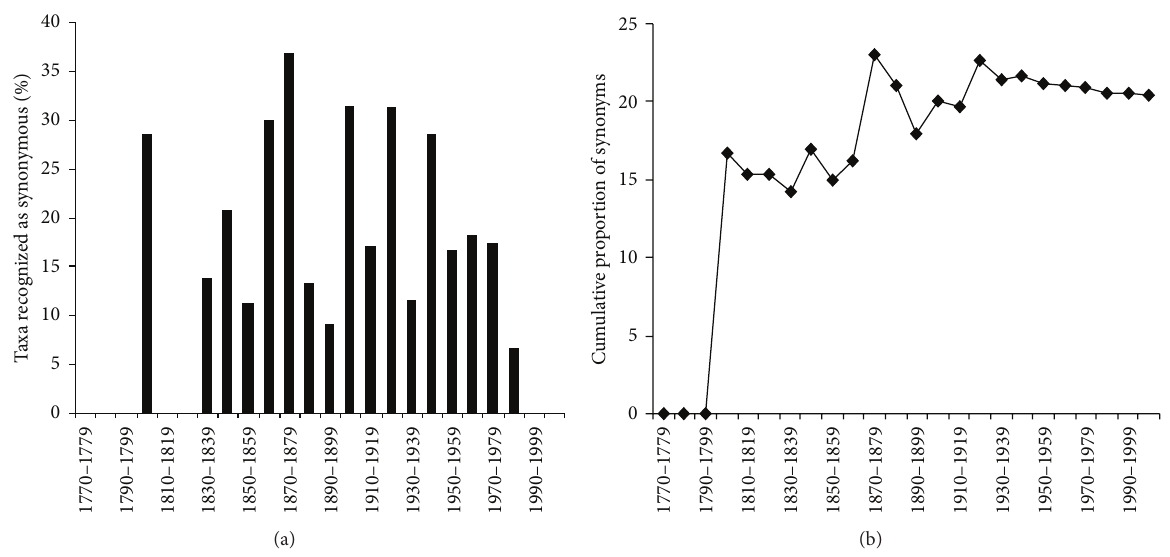
Figure 3: Percentages of synonymous taxa described in each decade (a) and their historical process of accumulation (b).